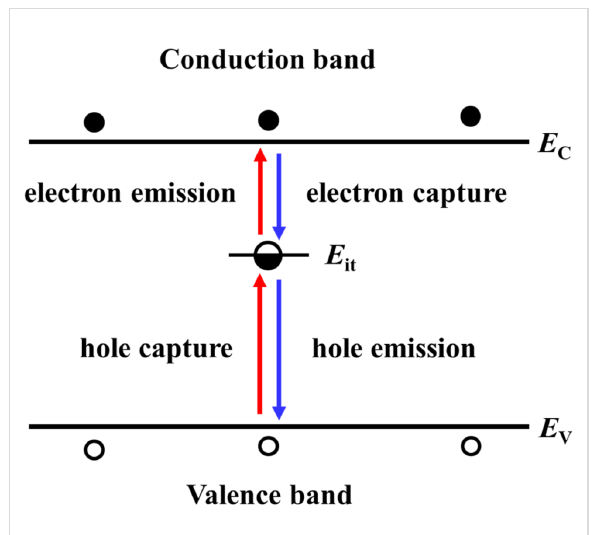
Figure 2: Schematic model of carrier emission and capture between the interface and bulk states of the semiconductor sample.